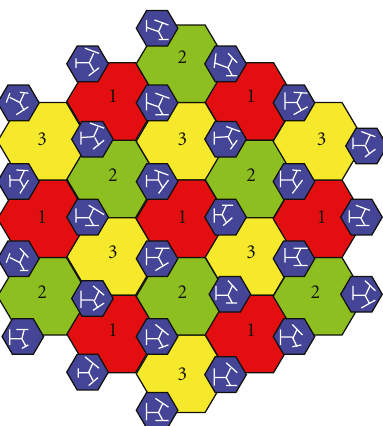
Figure 4: Cellular layout including the frequency reuse of 1/3 (colours/numbers of the